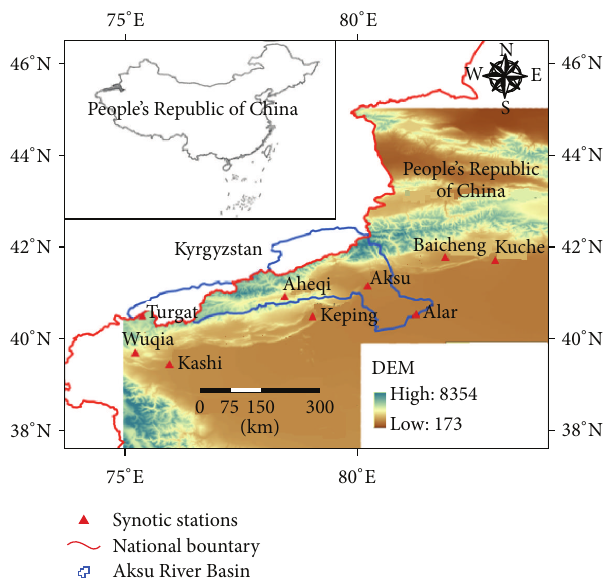
Figure 1: Location map of the 9 synoptic stations in Aksu River Basin of China.